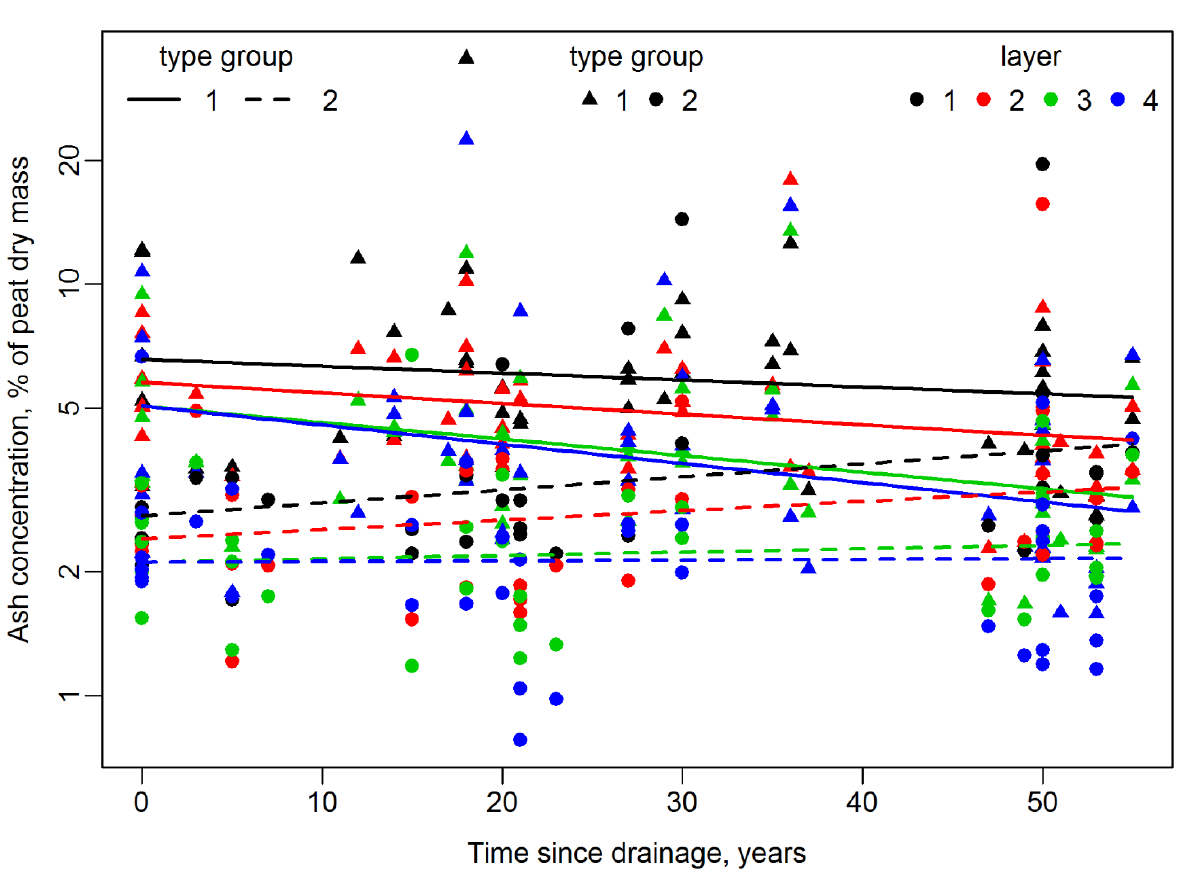
Figure A2. Fixed effects of the mixed linear model fitted into the log-transformed ash concentrations (lines). Triangles and dots show the original observations as in Figure A1.